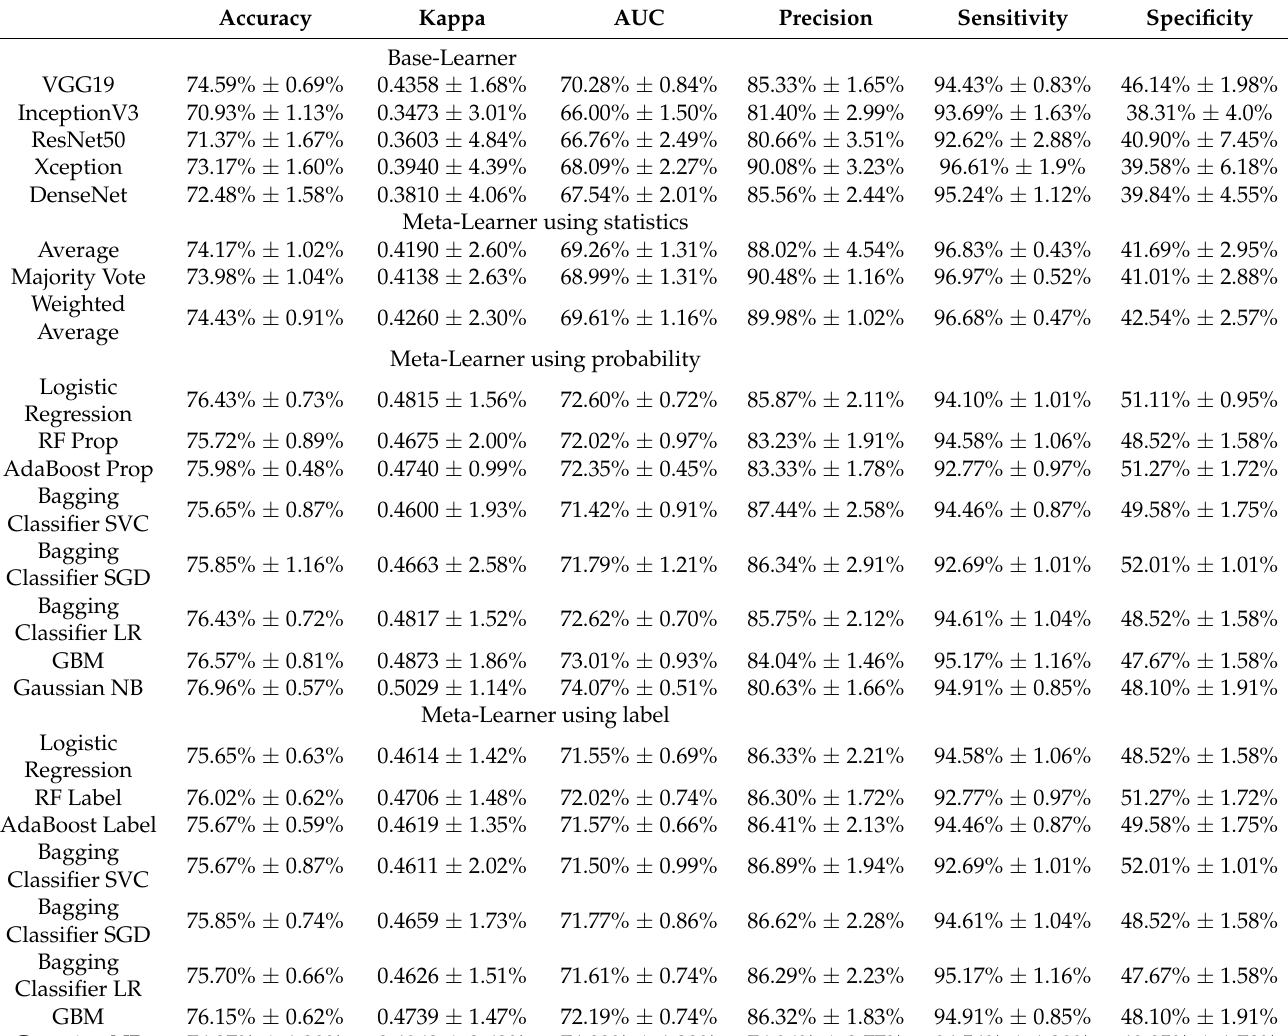
Table A6. The Kappa score achieved by each classifier for the hand images ( ± Confidence Interval 95%). Test performance is